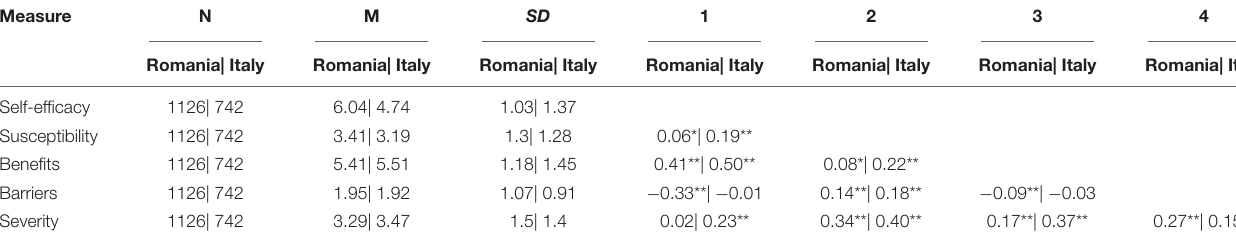
TABLE 3 | Correlation of the health belief facets in Romania and Italy.